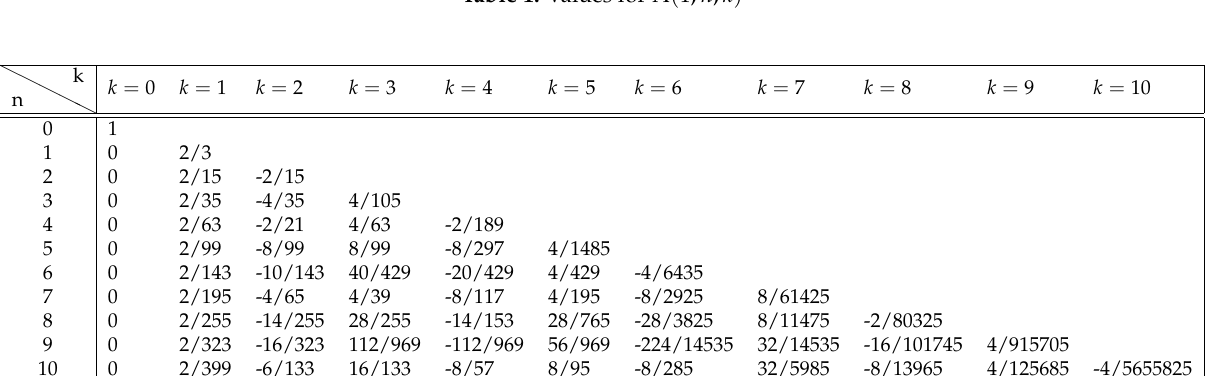
Table 1. Values for Λ ( 1, n , k )